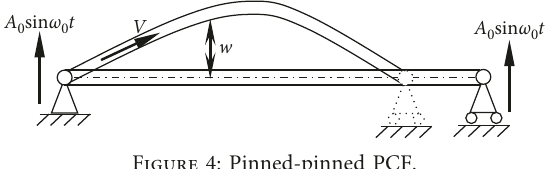
Figure 4: Pinned-pinned PCF.